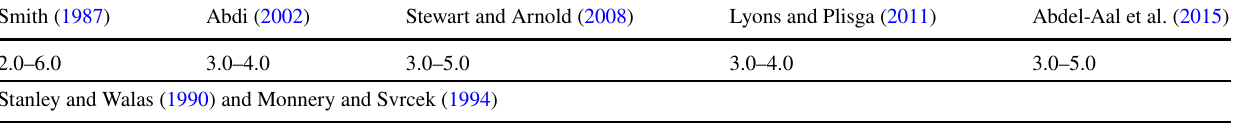
Table 1 Slenderness ranges proposed in the literature Smith